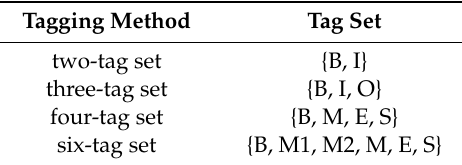
Table 2. Four cited mainstream tagging